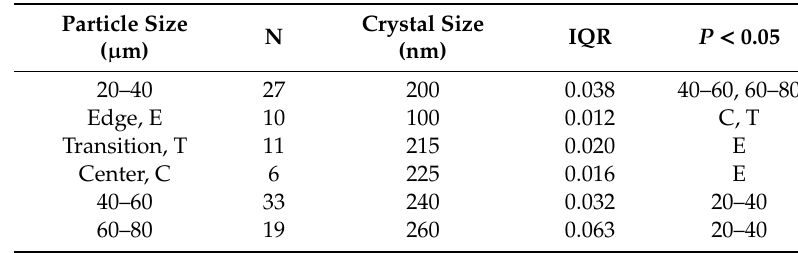
Table 1. Crystal size for splats made from di ff erently sized particles, and within a splat at positions E, T and C (median ± interquartile range, P < 0.05 indicates di ff erences between measurement groups outside the rejection region for a significance level of P = 0.05).